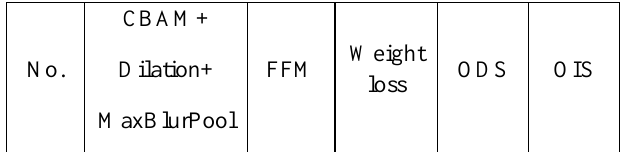
Table 2. Comparison of improvement effect